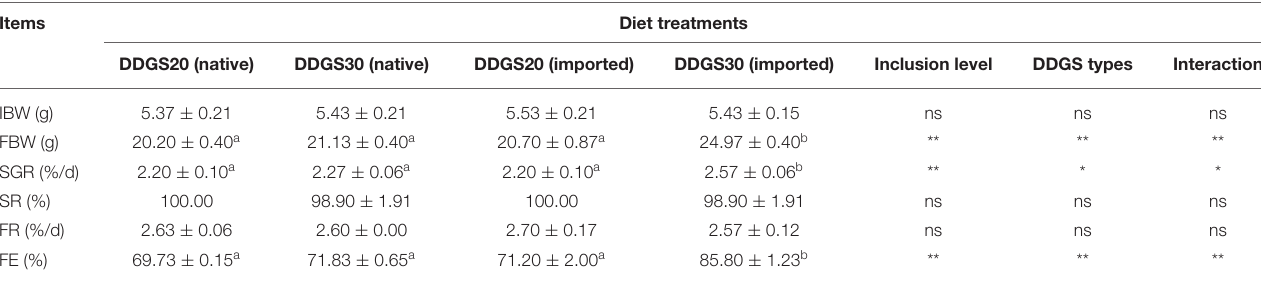
TABLE 3 | The effects of different types and levels of dietary dried distillers grains with solubles (DDGS) on the growth performance and feed utilization of juvenile grass carp a . Items